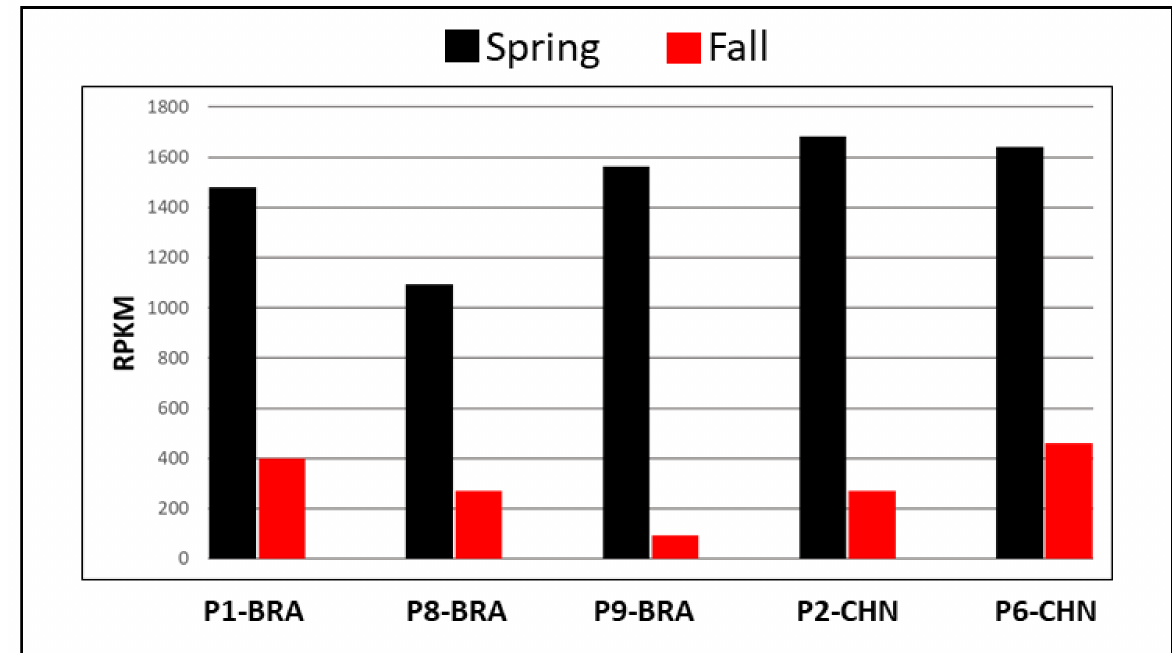
Figure 4. Spring and fall viral read comparison of two sugarcane yellow leaf virus (SCYLV) genotypes, Brazil (BRA) and China (CHN), in five sugarcane quarantine specimens. Viral reads are normalized as RPKM, reads per kilobase per million, to account for viral genome size [43]. The SCYLV-BRA genotype is represented by three samples (P1, P8, and P9), and the SCYLV-CHN genotype is represented by two samples (P2 and